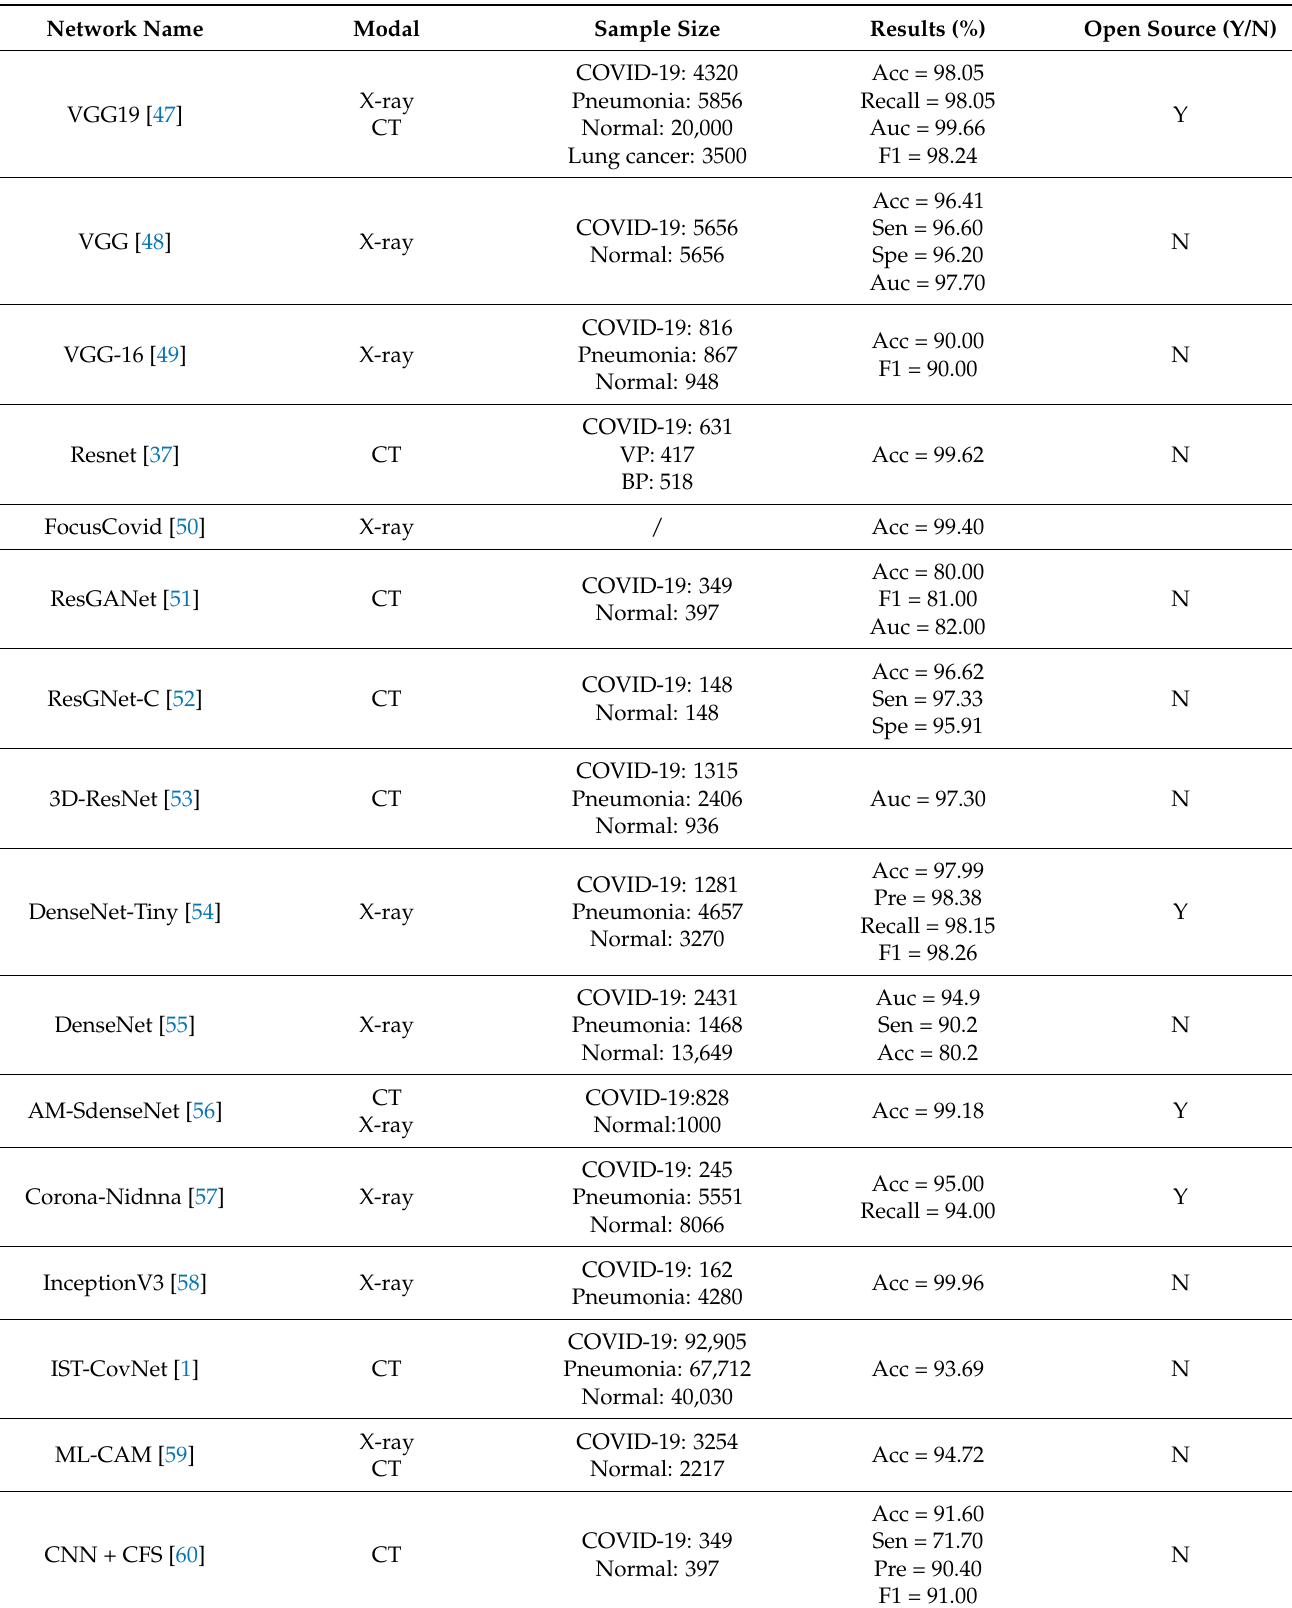
Table 2. COVID-19 classification methods based on supervised